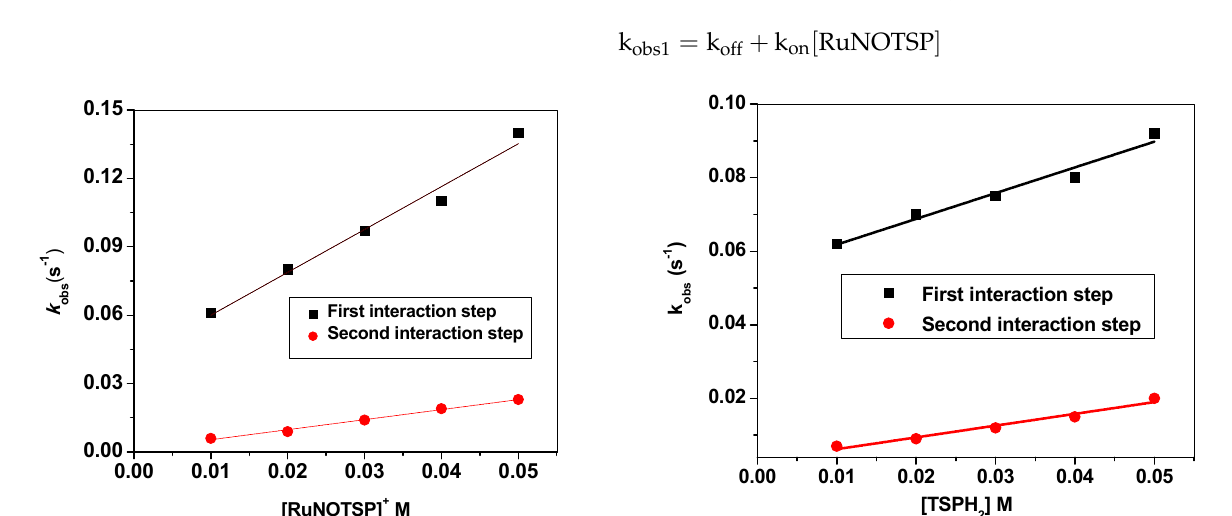
Figure 11. Plots of k obs vs. concentration of [RuNOTSP] + and its ligand TSPH 2 in methanol. Both k on and k o ff were used to obtain the equilibrium association constants (K a [M − 1 ] = (k on /k o ff ) and the equilibrium dissociation constants (K d [M] = k o ff /k on ). As shown in